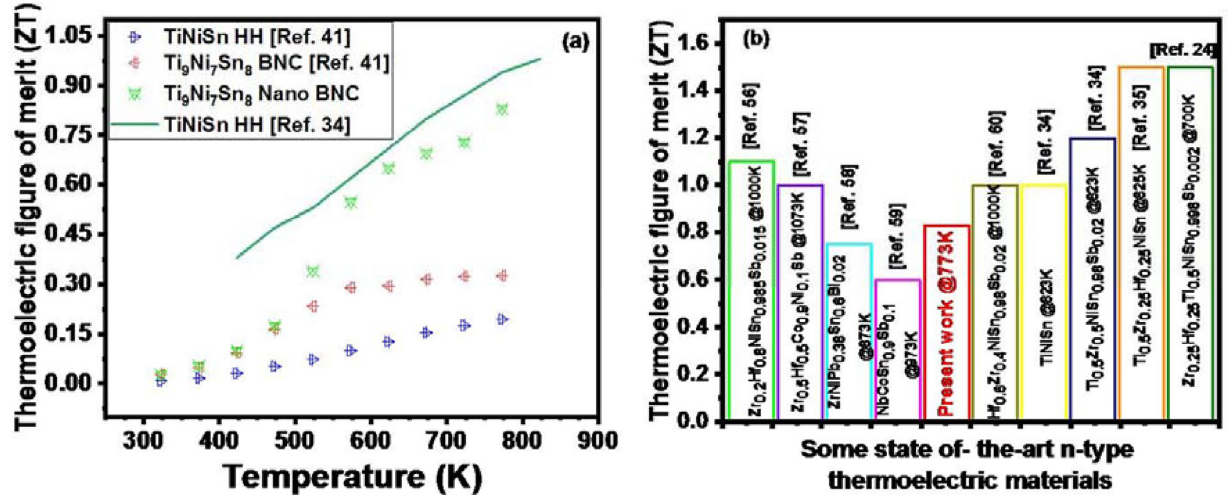
Fig. 7 a Temperature dependence of the thermoelectric figure of merit of Ti 9 Ni 7 Sn 8 Nano-BNC; b comparison of the thermoelectric figure of merit of Ti 9 Ni 7 Sn 8 Nano-BNC with some state-of-the-art N type thermoelectric